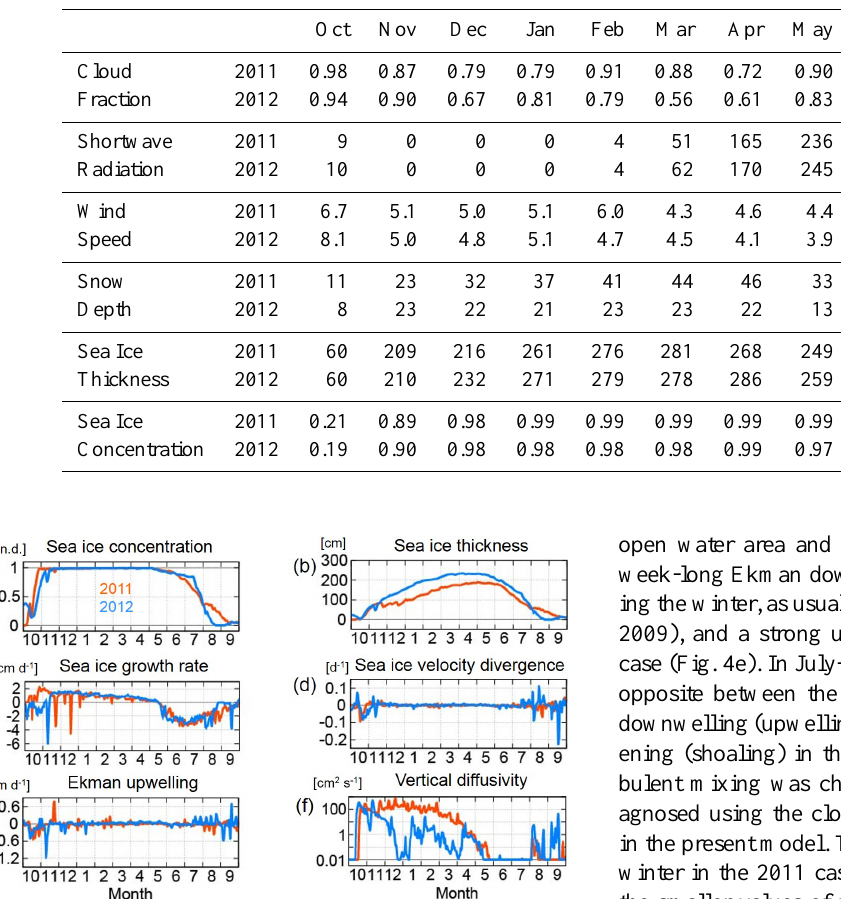
Table 2. Monthly mean values of NCEP/CFSR cloud fraction (n.d.), downward shortwave radiation (Wm − 2 ) , 10m wind speed (ms − 1 ) , snow depth (cm), sea ice thickness (cm), and sea ice concentration (n.d.) averaged in the NAP region. 2011 (2012) corresponds to the period